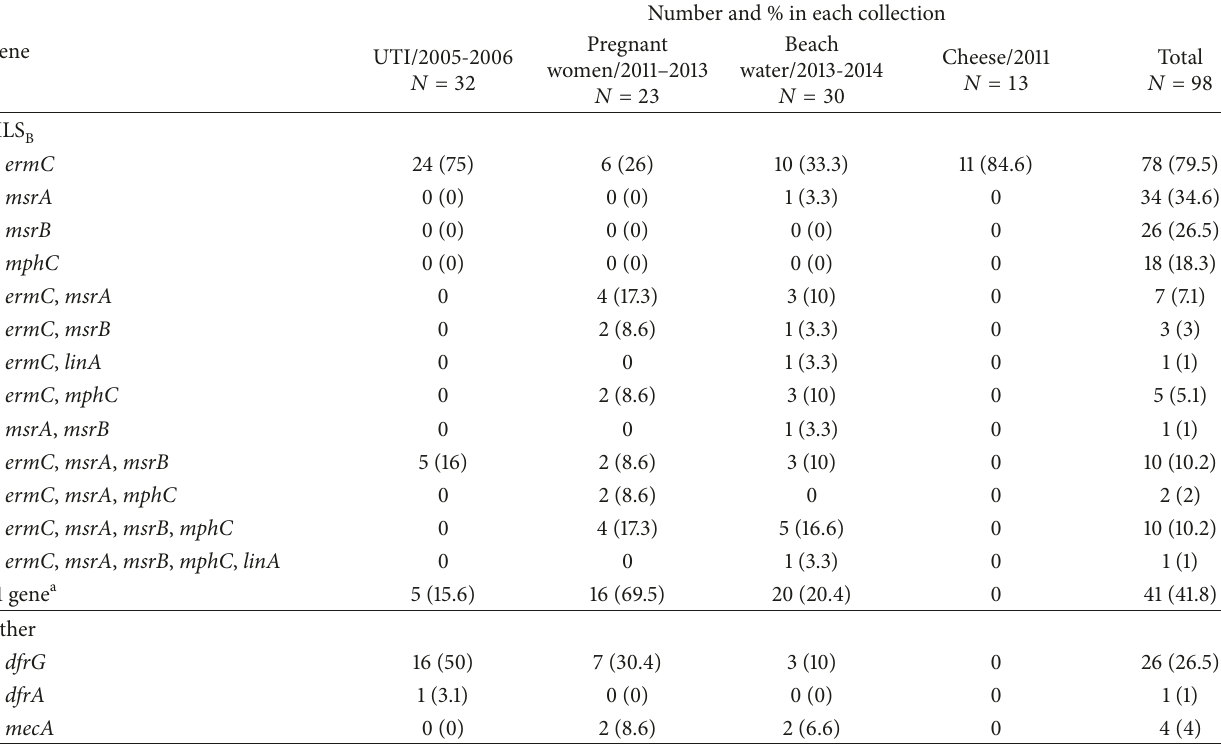
Table 4: Distribution of the antimicrobial resistance genes by sample source among the 98 Staphylococcus saprophyticus